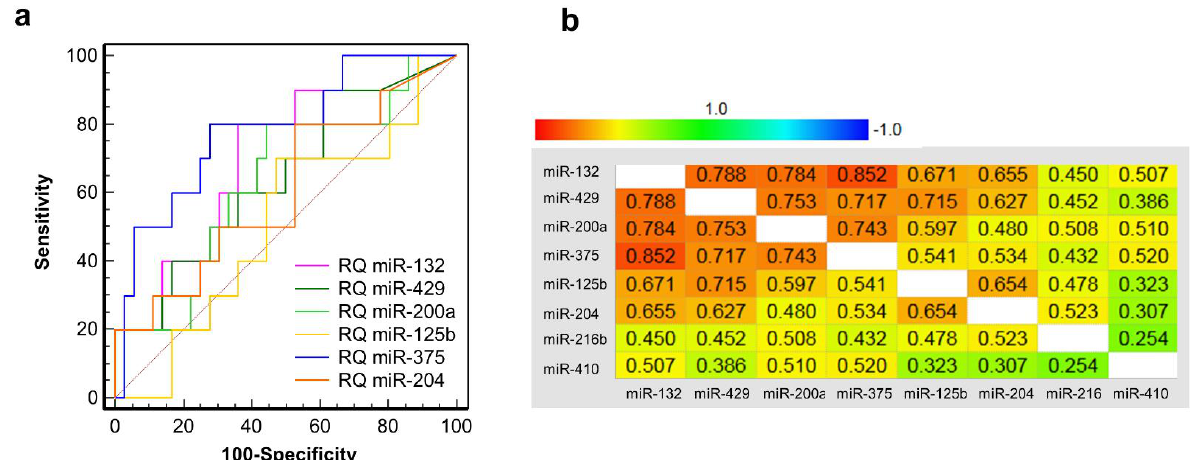
Figure 7. ROC analysis of endocrine-enriched microRNAs 1 h after transplantation to predict secretory graft function 2 months later. ( a ). Area under the receiver operating characteristics (AUC) of the indicated microRNAs in n = 46 intraportal islet transplantations, measured 1 h post-transplant, to predict a poor secretory graft function 23 months later (<0.5 ng/mL increment of C-peptide as compared to fasting C-peptide before transplantation). ( b ). Spearman rank correlation coefficients of the indicated microRNAs with a color grading ranging from low (blue) to high (red) correlation.